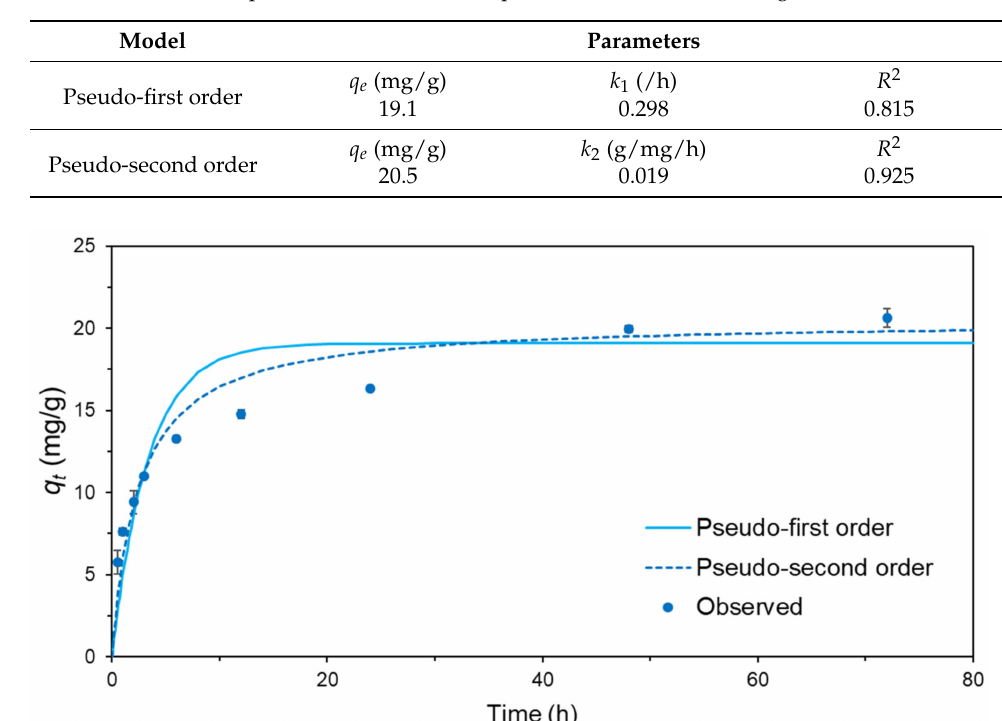
Figure 8. As(III) adsorption onto Al-FWB with respect to the reaction time and the kinetic model fits for the experimental data.